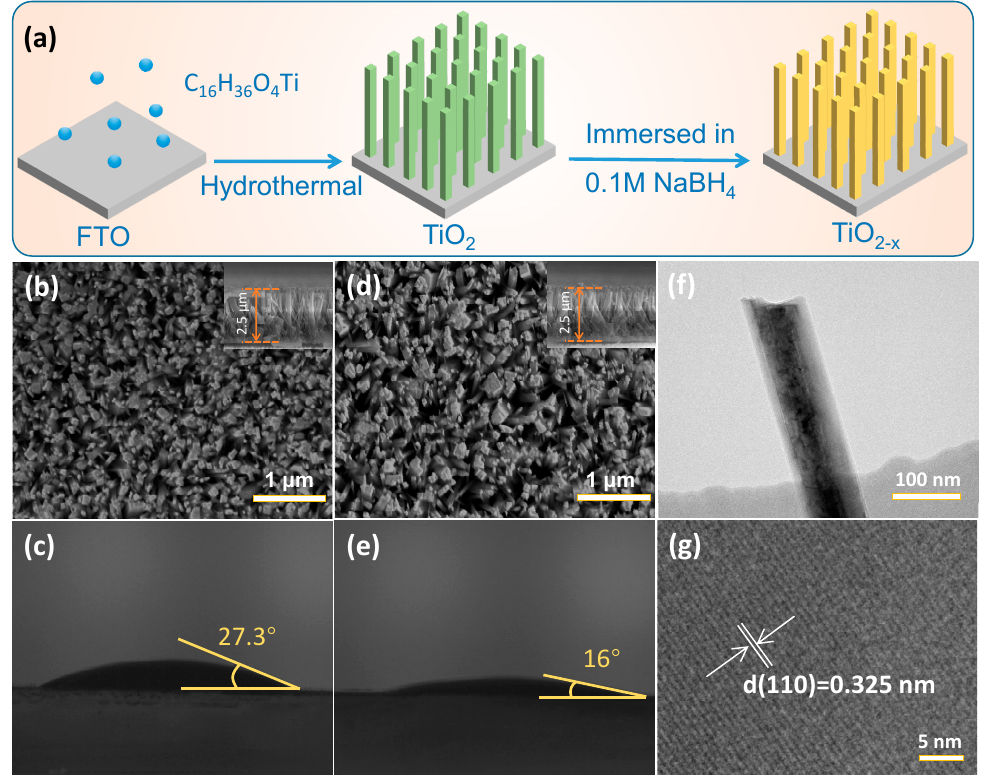
Figure 1. ( a ) Synthesis illustration of TiO 2-x photoanode; SEM of ( b )TiO 2 and ( d ) TiO 2-x ; ( f ) and ( g ) TEM images of TiO 2-x ; contact angles of water droplets on ( c ) TiO 2 and ( e ) TiO 2-x .